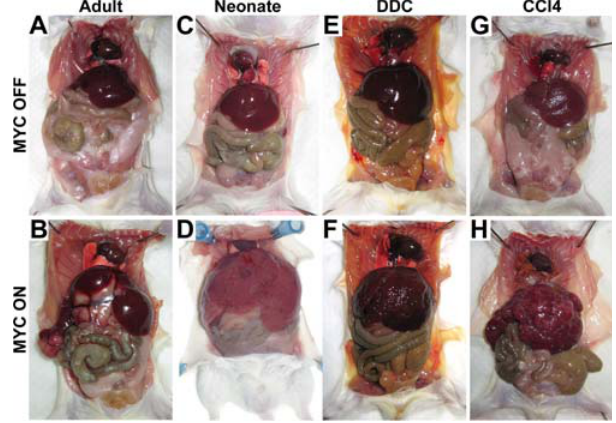
Figure 3. DDC and CCl 4 Cooperate with MYC to Induce Diffuse HCC. (A) A normal adult liver (MYC OFF Adult). (B) An adult liver tumor (MYC ON Adult). (C) A normal 4 w old liver (MYC OFF Neonate). (D) A neonatal liver tumor (MYC ON Neonate). (E) An adult liver 3–4 weeks after continuous DDC treatment (MYC OFF/DDC). (F) An adult liver tumor induced by MYC overexpression in conjunction with continuous DDC treatment (MYC ON/DDC). (G) An adult liver 4 weeks after continuous CCl 4 treatment (MYC OFF/CCl 4 ). (H) An adult liver tumor induced by MYC overexpression in conjunction with continuous CCl 4 treatment (MYC ON/CCl 4 ). Representative animals from each cohort are presented. Note that toxin-accelerated HCC are diffuse, similar in appearance to neonatal tumors. In contrast, normal MYC-induced adult tumors present as a distinct, multifocal disease.